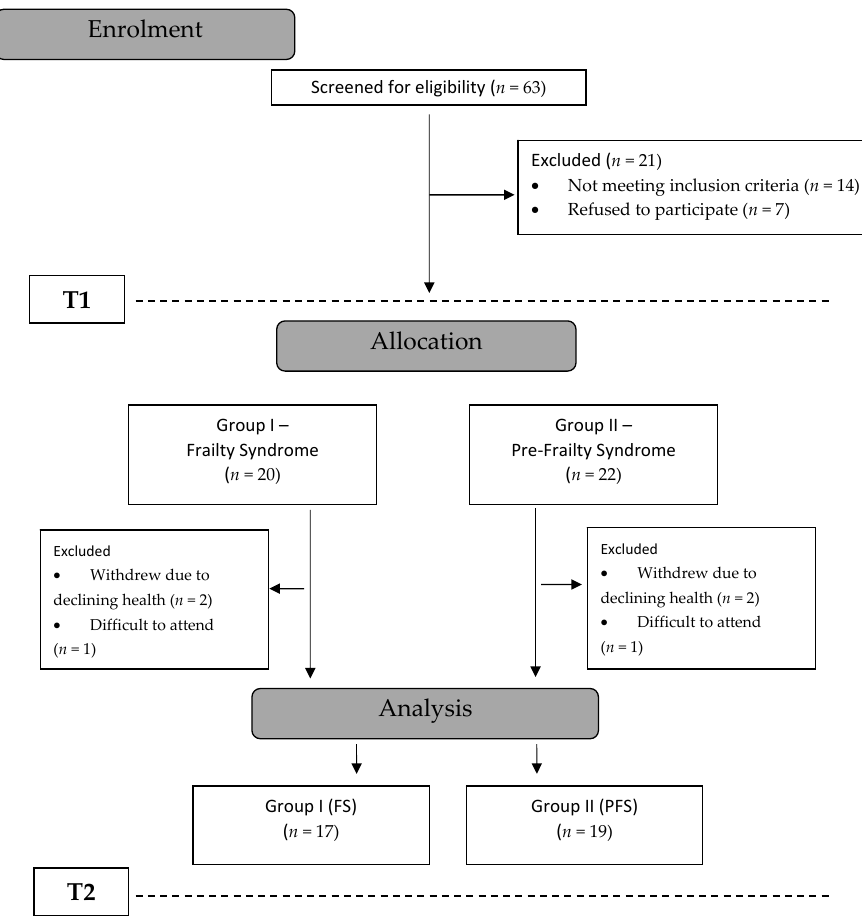
Figure 1. Design and flow of participants throughout the